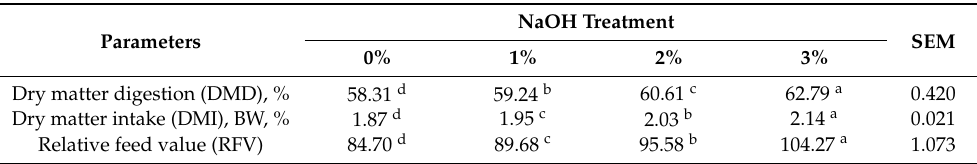
Table 3. Effects of NaOH treatment on digestibility, dry matter intake, and relative feed values of reed straws.